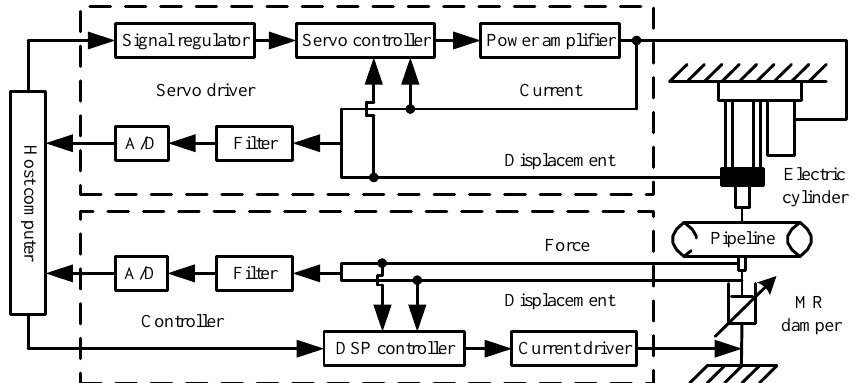
Figure 10. Pipeline vibration measurement and control system based on MR damper.